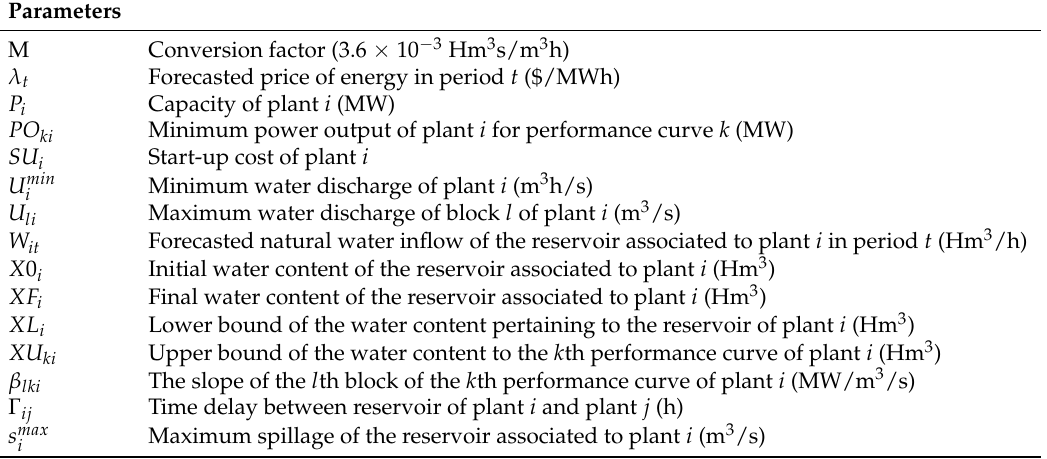
Table A2. Parameters.